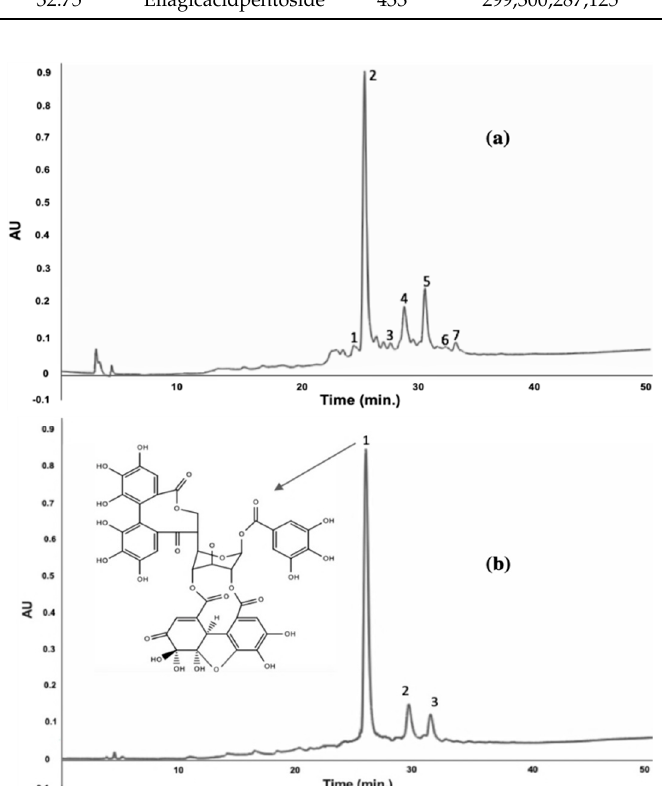
Figure 6. Chromatogram of the best extraction condition of RP 1:16-0 with the first and the second purification ( a ) 1 corilagin; 2 geraniin; 3 punigluconin; 4 ellagic acid pentoside; 5 ellagic acid; 6 tetragalloy glucose; 7 pedunculagin. ( b ) 1 geranin; 2 ellagic acid; 3 ellagic acid pentoside at 280 nm.